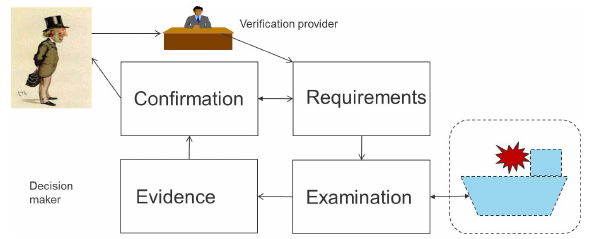
Figure 1: Illustration of the verification